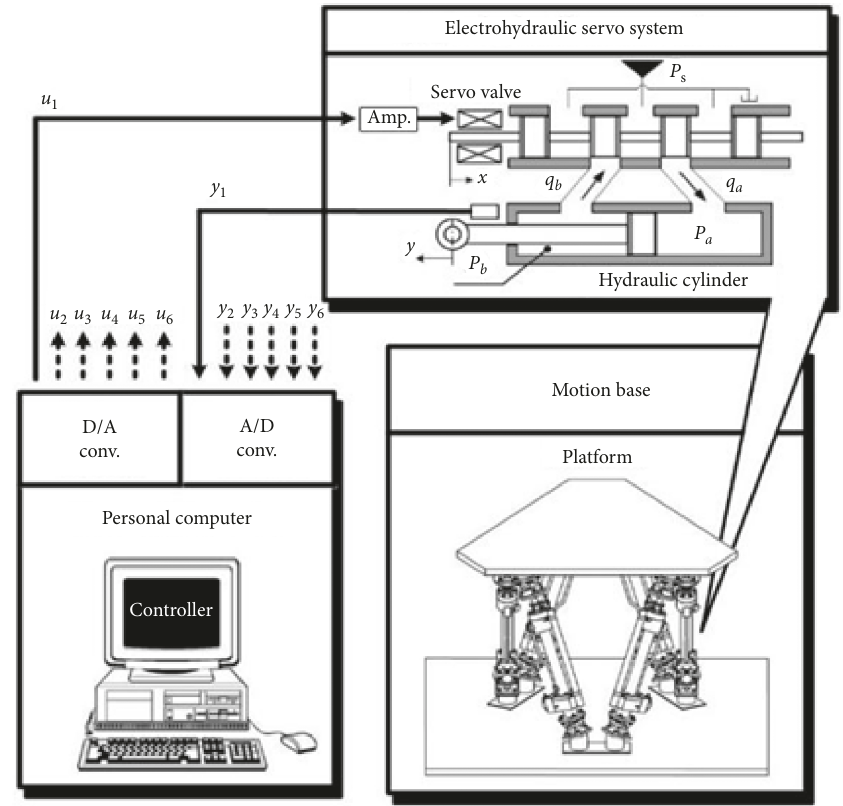
Figure 2: Principle of a closed-loop control of the hydraulic servo control system.